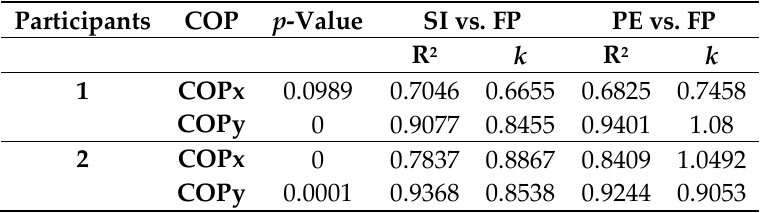
Table 1. Comparison of coefficient of determination (R 2 ) and gradient of the fit function ( k ) of the centre of pressure (COPx and COPy) between smart (SI) and Pedar (PE) insoles